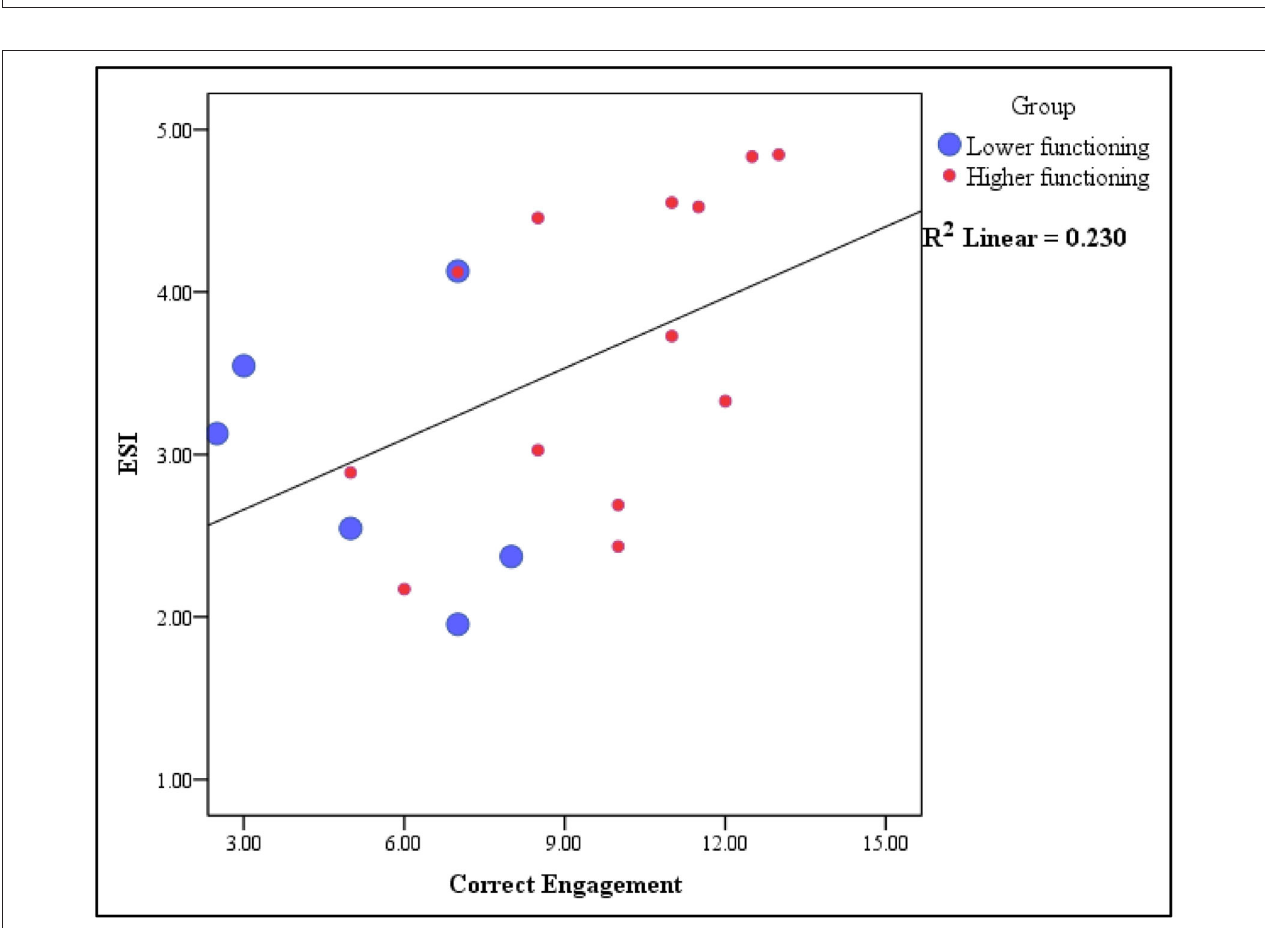
FIGURE 4 | Simple regression model analysis for lower (blue) and higher (red) functioning PwD. Correlation between the aggregate correct engagement scores and the average ESI assessments.